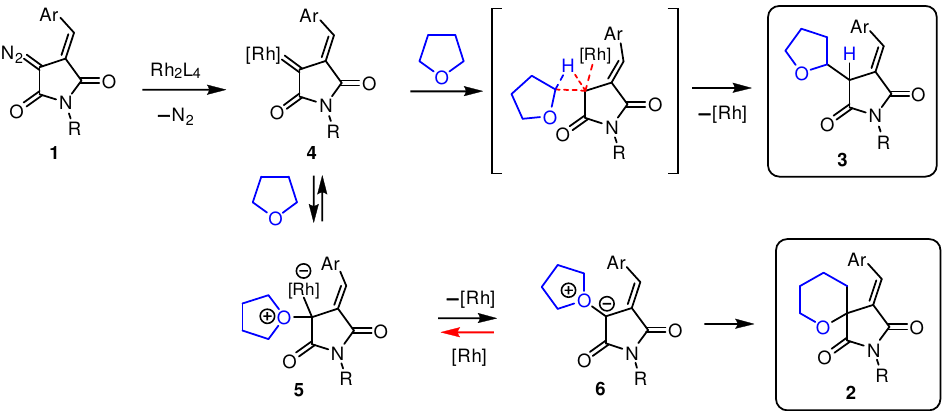
Scheme 2. Plausible mechanistic picture accounting for the formation of compounds 2 and 3 .